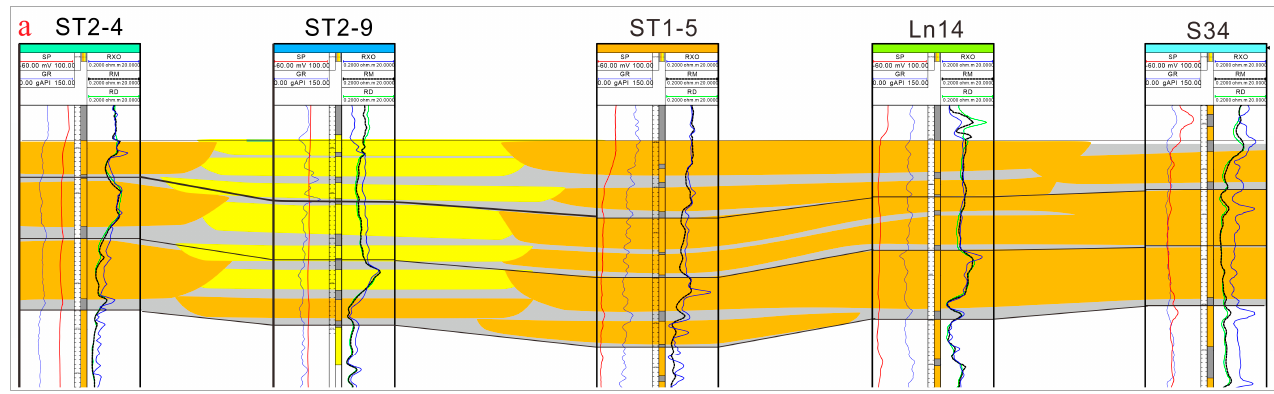
Figure 7. Single well architecture interpretation in the Sangtamu oilfield (( a ) well LN22, ( b ) well ST2-8J).